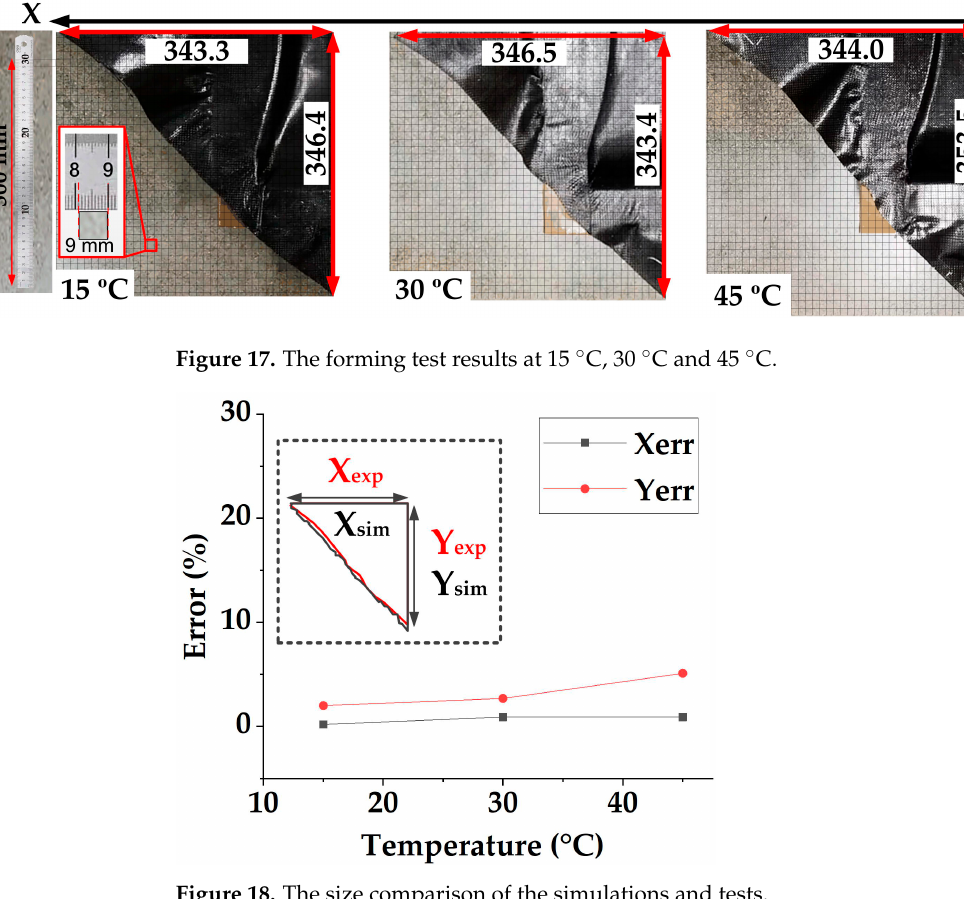
Figure 18. The size comparison of the simulations and tests.